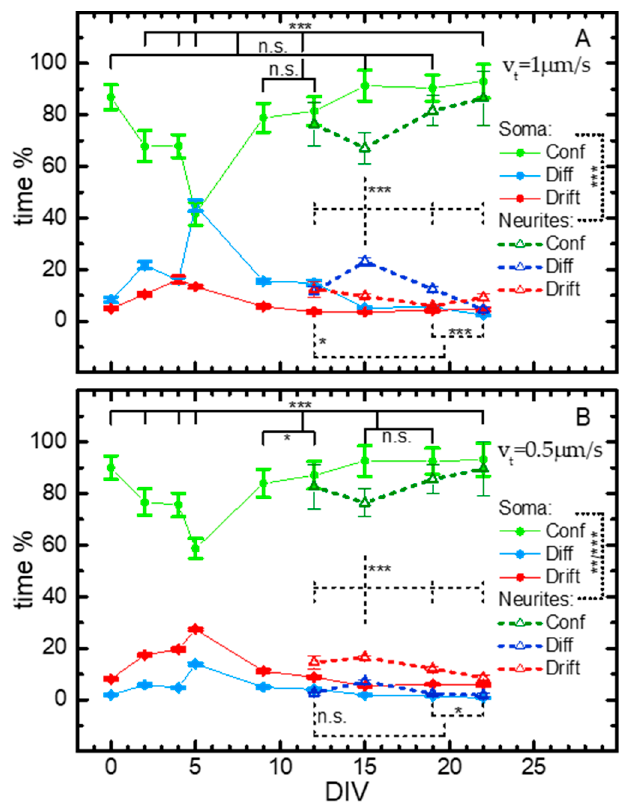
Figure 6. Dependence on DIV of the distributions (in %) for the time spent by lysosomes in confined (Conf), diffusive (Diff), and drifted (Drift) motion during neural differentiation, within cell bodies (DIV0-22, dots and solid lines) and projections (DIV12-22, triangles and dashed lines). Velocity threshold for drifted subtrajectories in the first analysis step (see text) v t = 1.0 μ m/s ( A ) and 0.5 μ m/s ( B ). The differences at different DIVs were very highly significant ( p < 10 − 20 ) within each case (soma or projections), according to a χ 2 test (see Section 4 for tests and uncertainties). Distributions in soma and dendrites were highly significantly different at each considered DIV. (Bonferroni-adjusted) p -values for single comparisons: n.s. >0.05; * <0.05; ** <0.01; *** <0.0015. All the statistical data for these graphs are reported in Table S2.